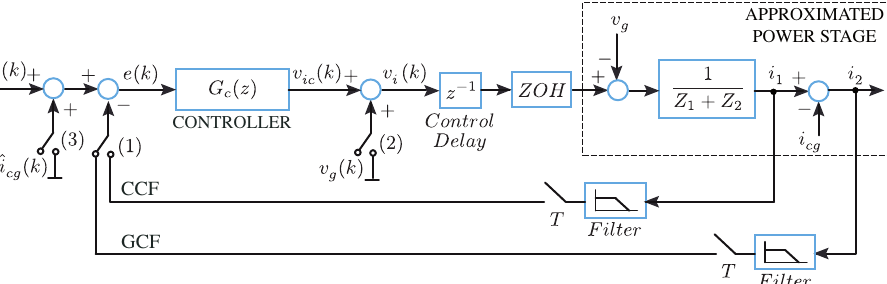
Figure 3. Plant model approximation for low frequencies with anti-aliasing filter, controller and control delay.